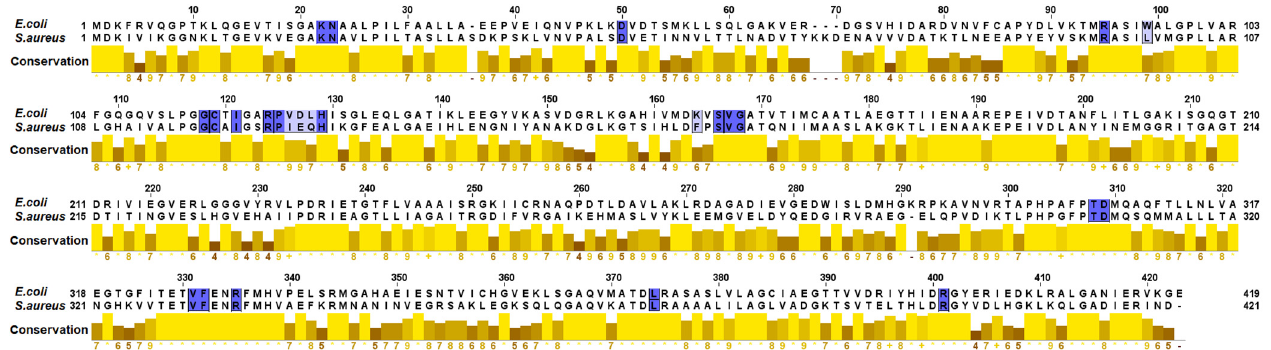
Figure 2. Conservation of amino acids (colored blue) within 4 Å from the PEP and UDP-GlcNAc binding sites in Escherichia coli and Staphylococcus aureus MurA enzymes.